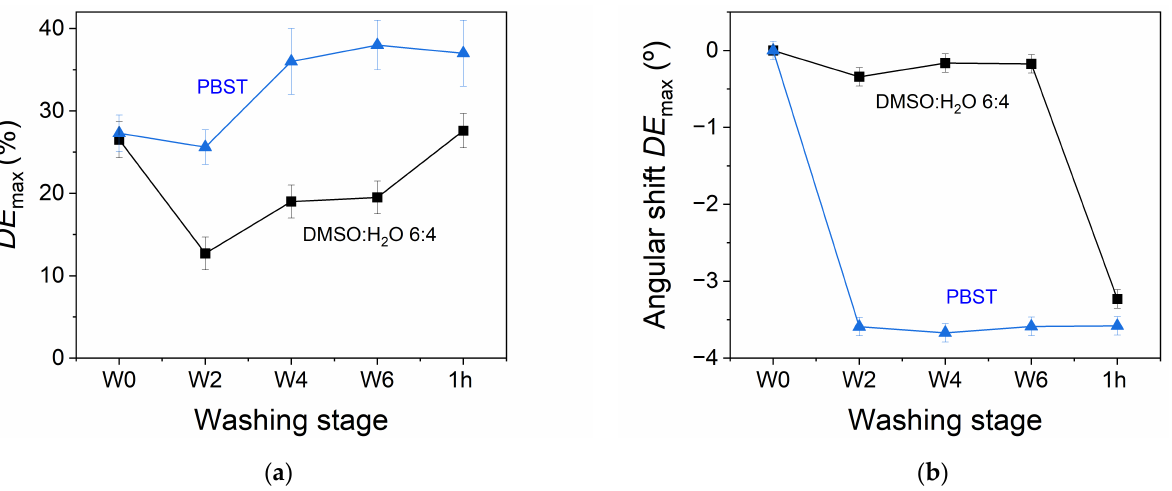
Figure 7. ( a ) Maximum diffraction efficiency ( DE max ) and ( b ) angular shifts with respect to the reconstruction angle of holographic hydrogels after the different for the washing stages with the two solvents used: DMSO:H 2 O 6:4 (black square) and PBST (blue triangle). W0 indicates no washing.